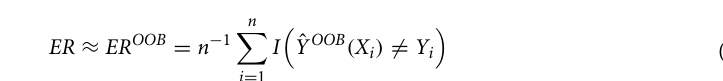
Table 3. OOB errors, number of trees and number of features at each split are tabulated for both experiment I, II, III.